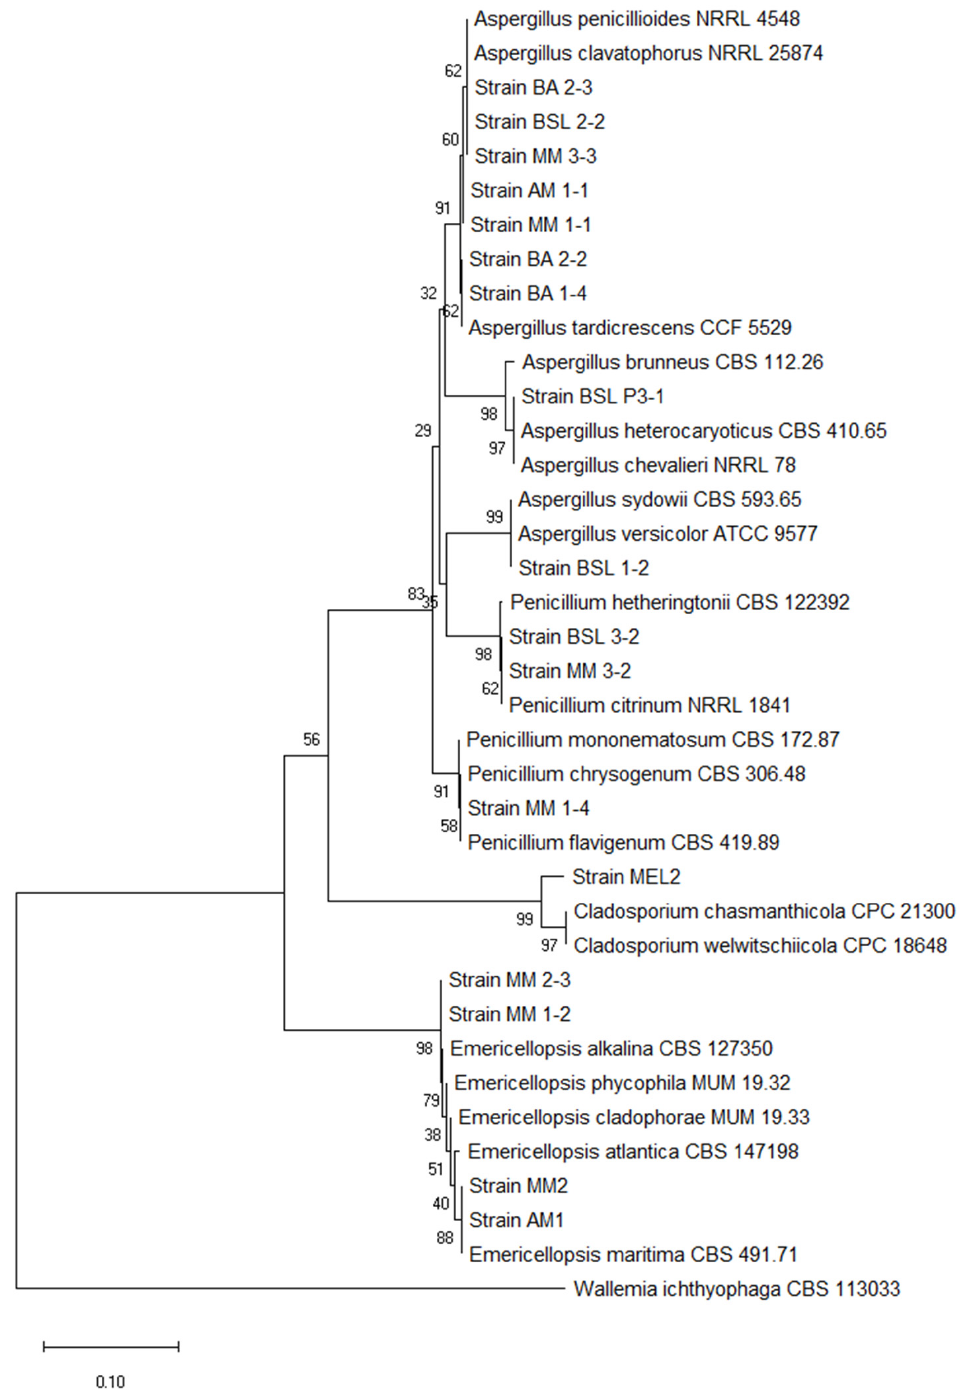
Figure 2. Neighbor-joining phylogenetic tree based on the analysis of the ITS regions of the fungal isolates.